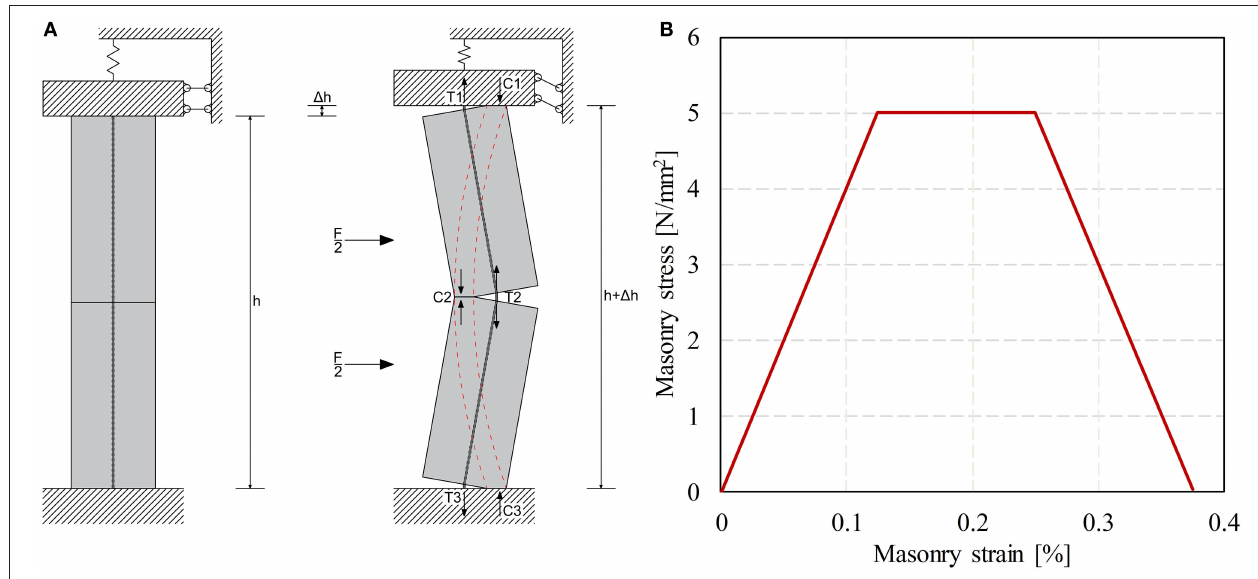
FIGURE 16 | Static scheme of infill wall model (A) ; stress-strain law of masonry in compression (B)